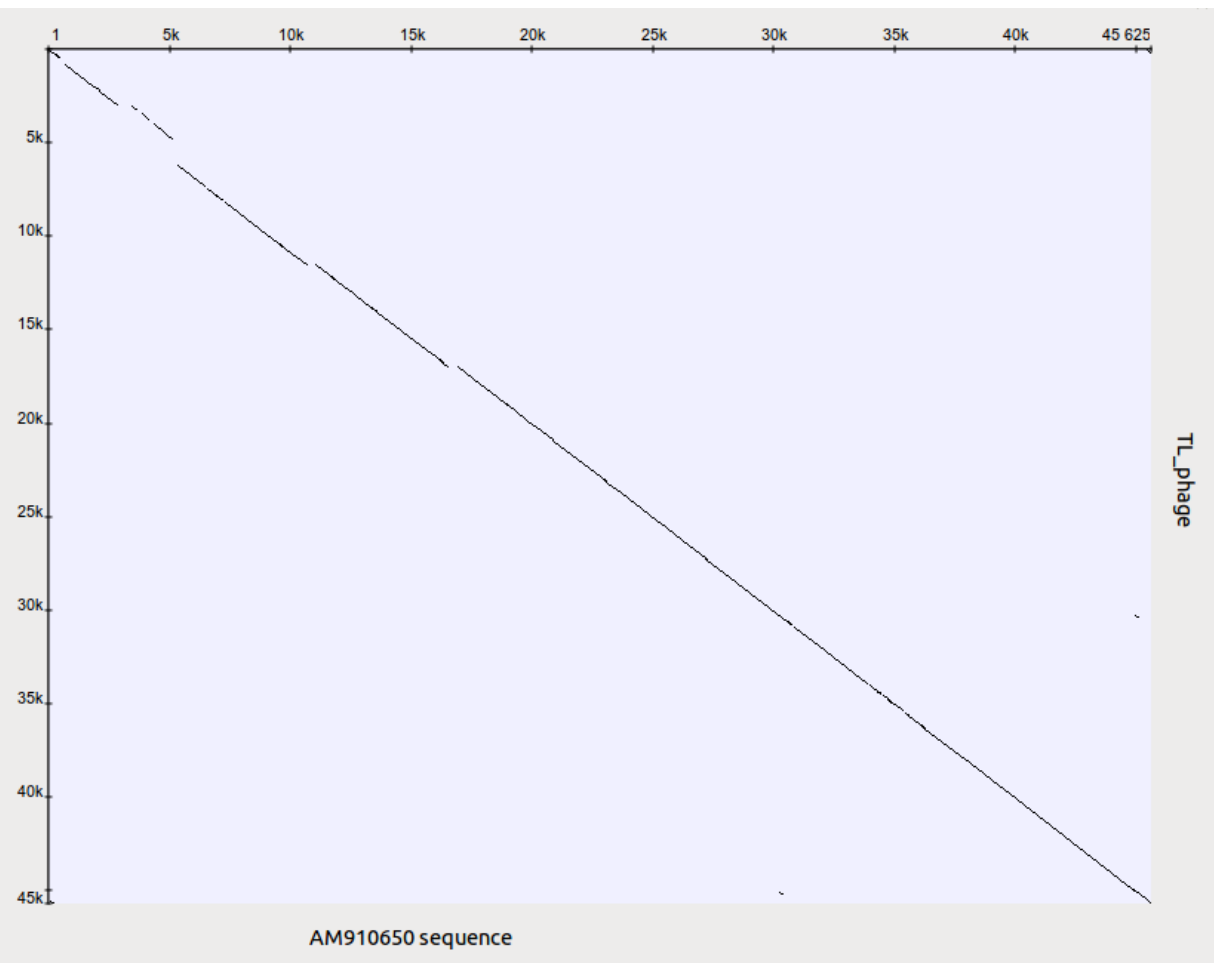
Figure 11. Genomes of phages TL and Luz24 have a high level of DNA homology (DotPlot on UGENE program parameters: 60 bp, 85% similarity) but TL genome contains transposase gene in the region of non-homology with